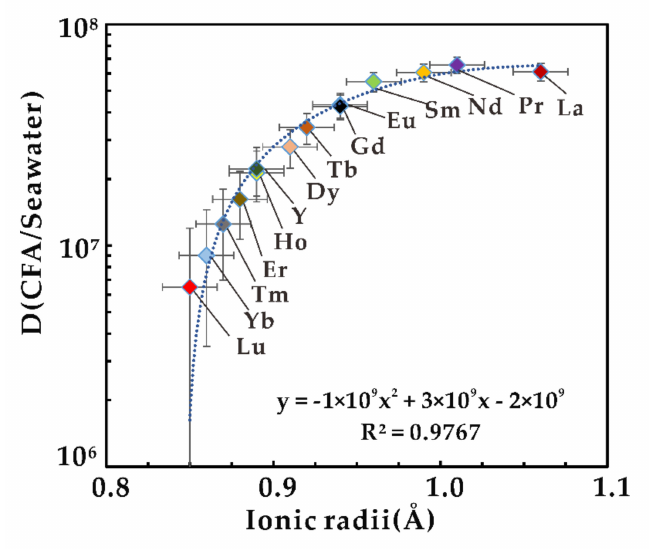
Figure 10. Apatite-seawater REY partition coe ffi cients as a function of ionic